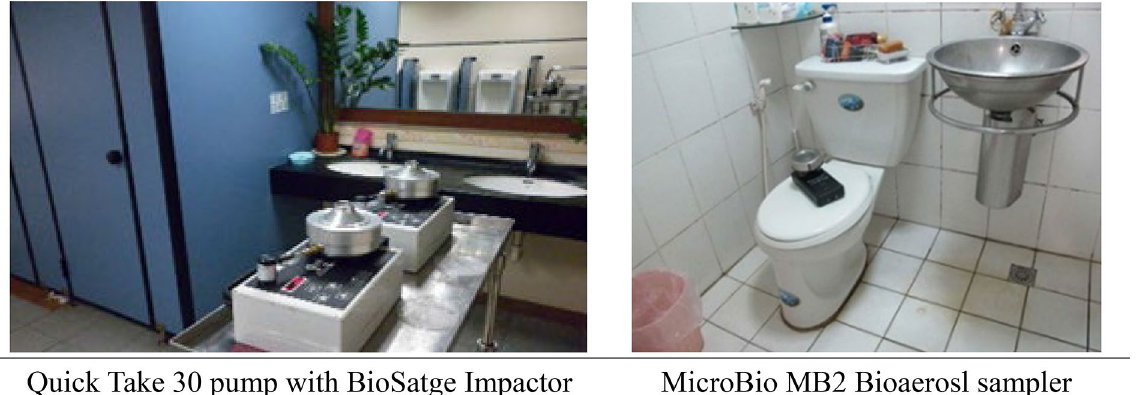
Figure 1. Two types of bioaerosl samplers in the field survey, and the position of the sampling entry for